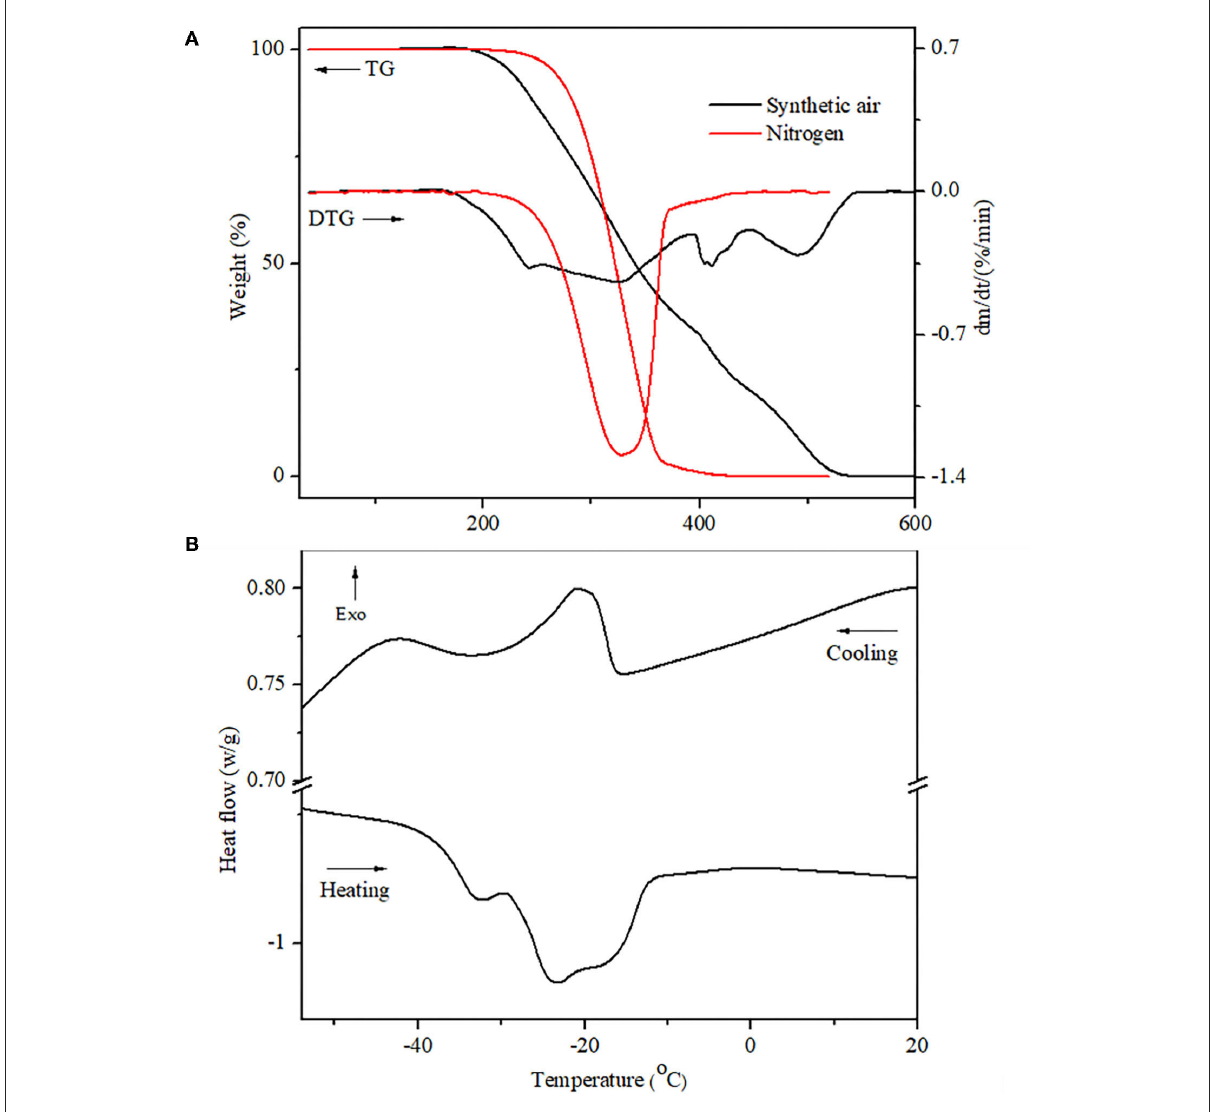
FIGURE2 Thermal analyses of the sunflower oil. (A) TGA/DTG curves at 2 ◦ C min − 1 heating from 10 to 550 ◦ C, under synthetic air and nitrogen atmospheres flow at 60ml min − 1 in dynamic conditions; (B) DSC curves of cooling and heating under the nitrogen